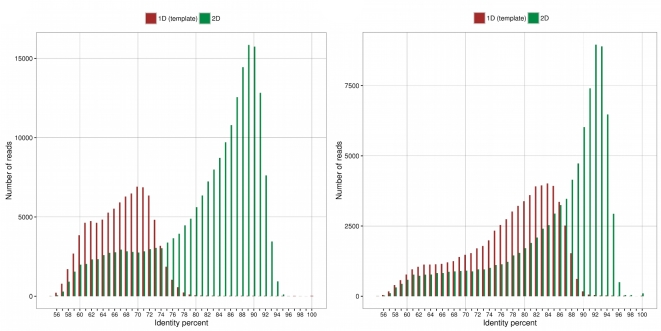
Identity distribution of Nanopore reads. Percent identity of the aligned MinION 1D (red bars) and 2D (green bars) reads. The MinION reads were aligned using LAST software. (a) R7.3 chemistry. (b) R9 chemistry.